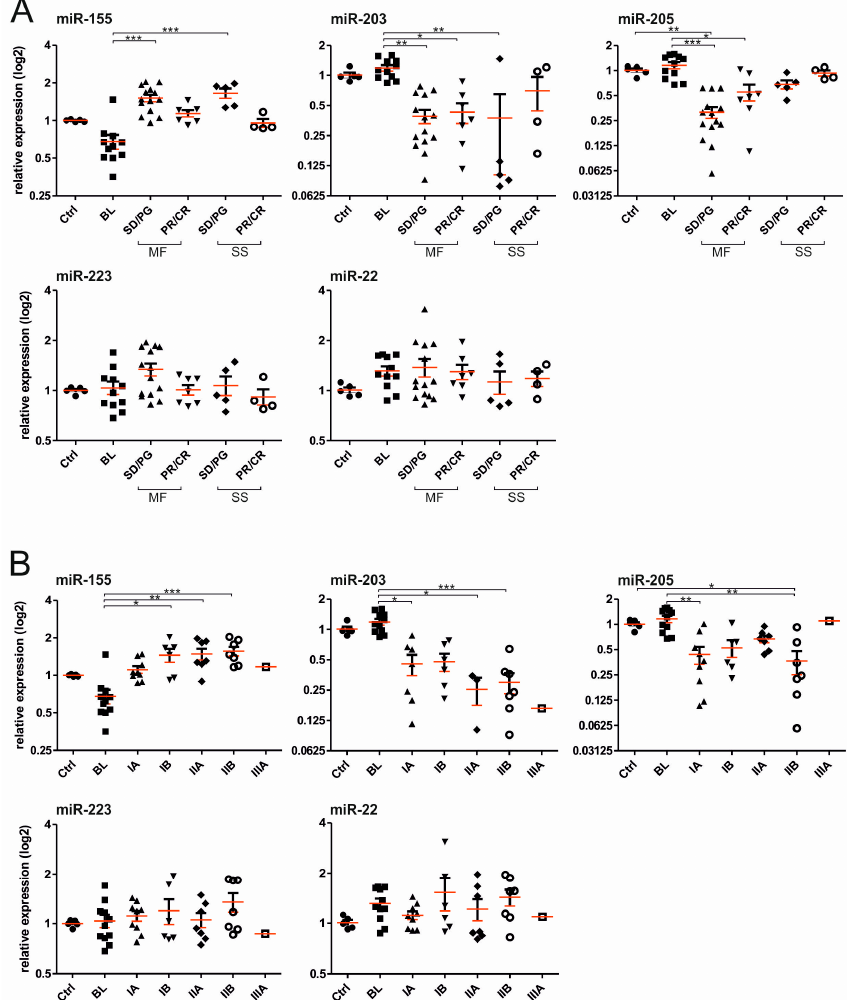
Figure 3. Plasma miR levels and CTCL clinical outcome. miR levels (in log2 scale) shown in respect to ( A ) therapeutic response; and ( B ) clinical stages. Ctrl: healthy control, Abbreviations: BL, MF, SS, SD, CR, PR or PG are described within the text and Table 1. Mean ± SD using the Kruskal-Wallis one-way ANOVA test. * p = 0.05, ** p = 0.01, *** p = 0.001.